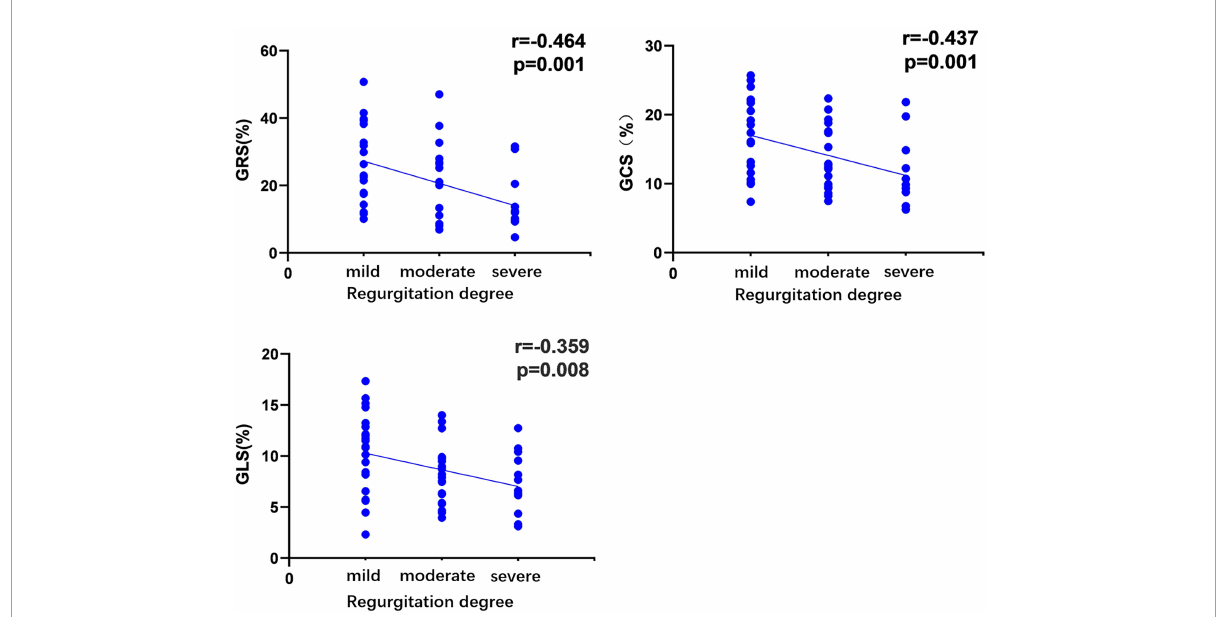
FIGURE4 Correlation of regurgitation degree in hypertensive patients with left ventricular global peak strain. The absolute values of the circumferential and longitudinal-peak strain were analyzed to avoid the effect of the directional sign. r, correlation coefficient; GRS, global radial peak strain; GCS, global circumferential peak strain; GLS, global longitudinal peak strain.